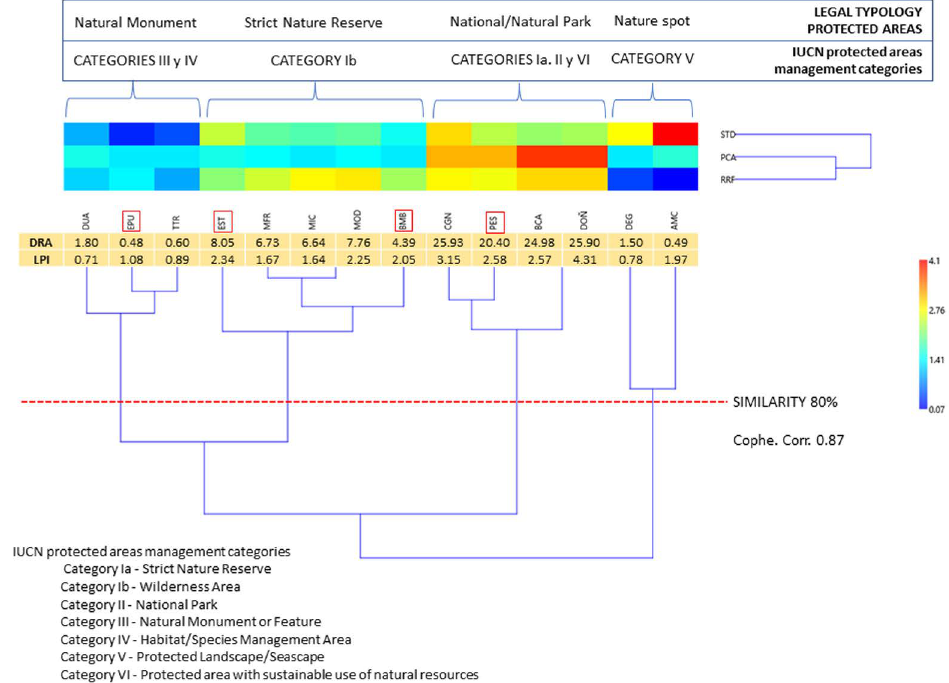
Figure 7. Comparison of the values of the Legal Protection Index (LPI) and the ARD Index proposed and the clusters derived from DRA values. Framed in red are those PAs whose assigned categories do not correspond to the DRA values obtained: EPU, EST, BMB and